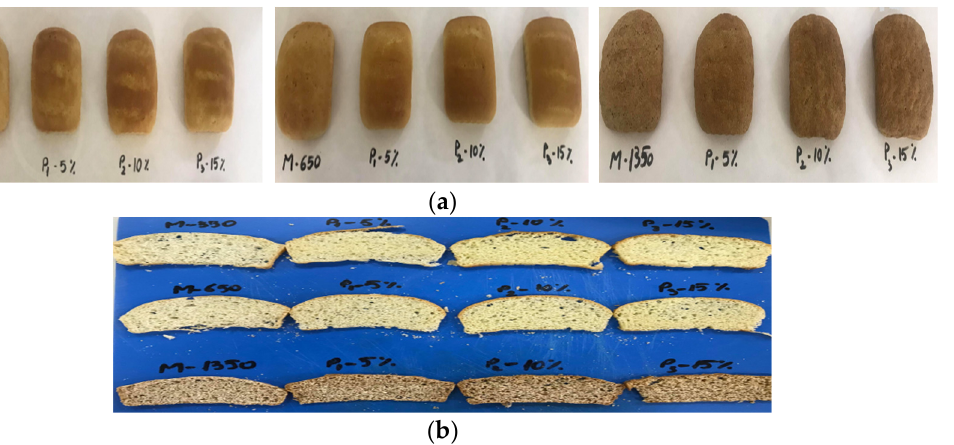
Figure 1. ( a ) Bread samples obtained from the three types of flour (external appearance); ( b ) Section appearance of bread samples .